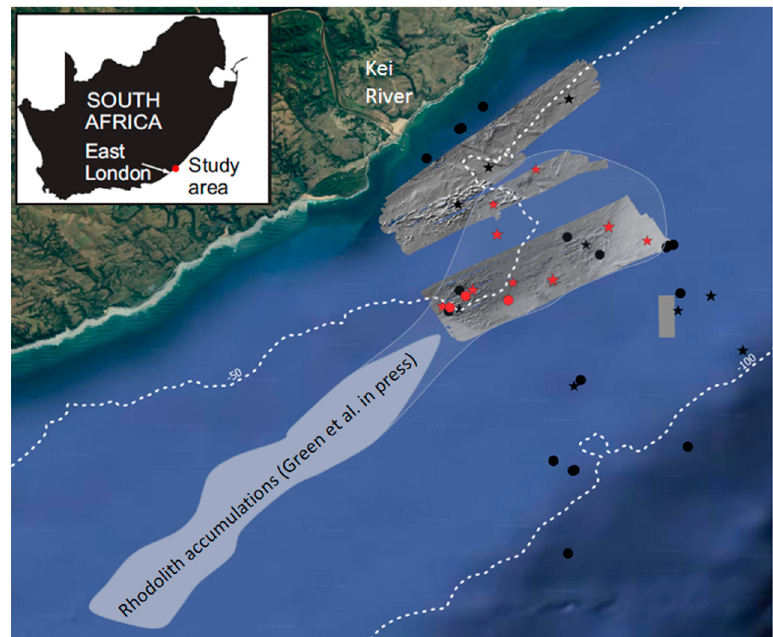
Figure 1. Speculated extent of rhodolith beds derived from seismic surveys (grey polygon), proposed extent of live rhodolith aggregations (light grey polygon) derived from remotely operated vehicle (ROV) surveys (red stars); dredge sampling (red circles) and multibeam bathymetry (greyscale relief) off the Kei River mouth, South Africa. Black stars and circles are ROV and dredge locations, respectively, which had no rhodoliths. The 50 m and 100 m isobaths are also depicted.